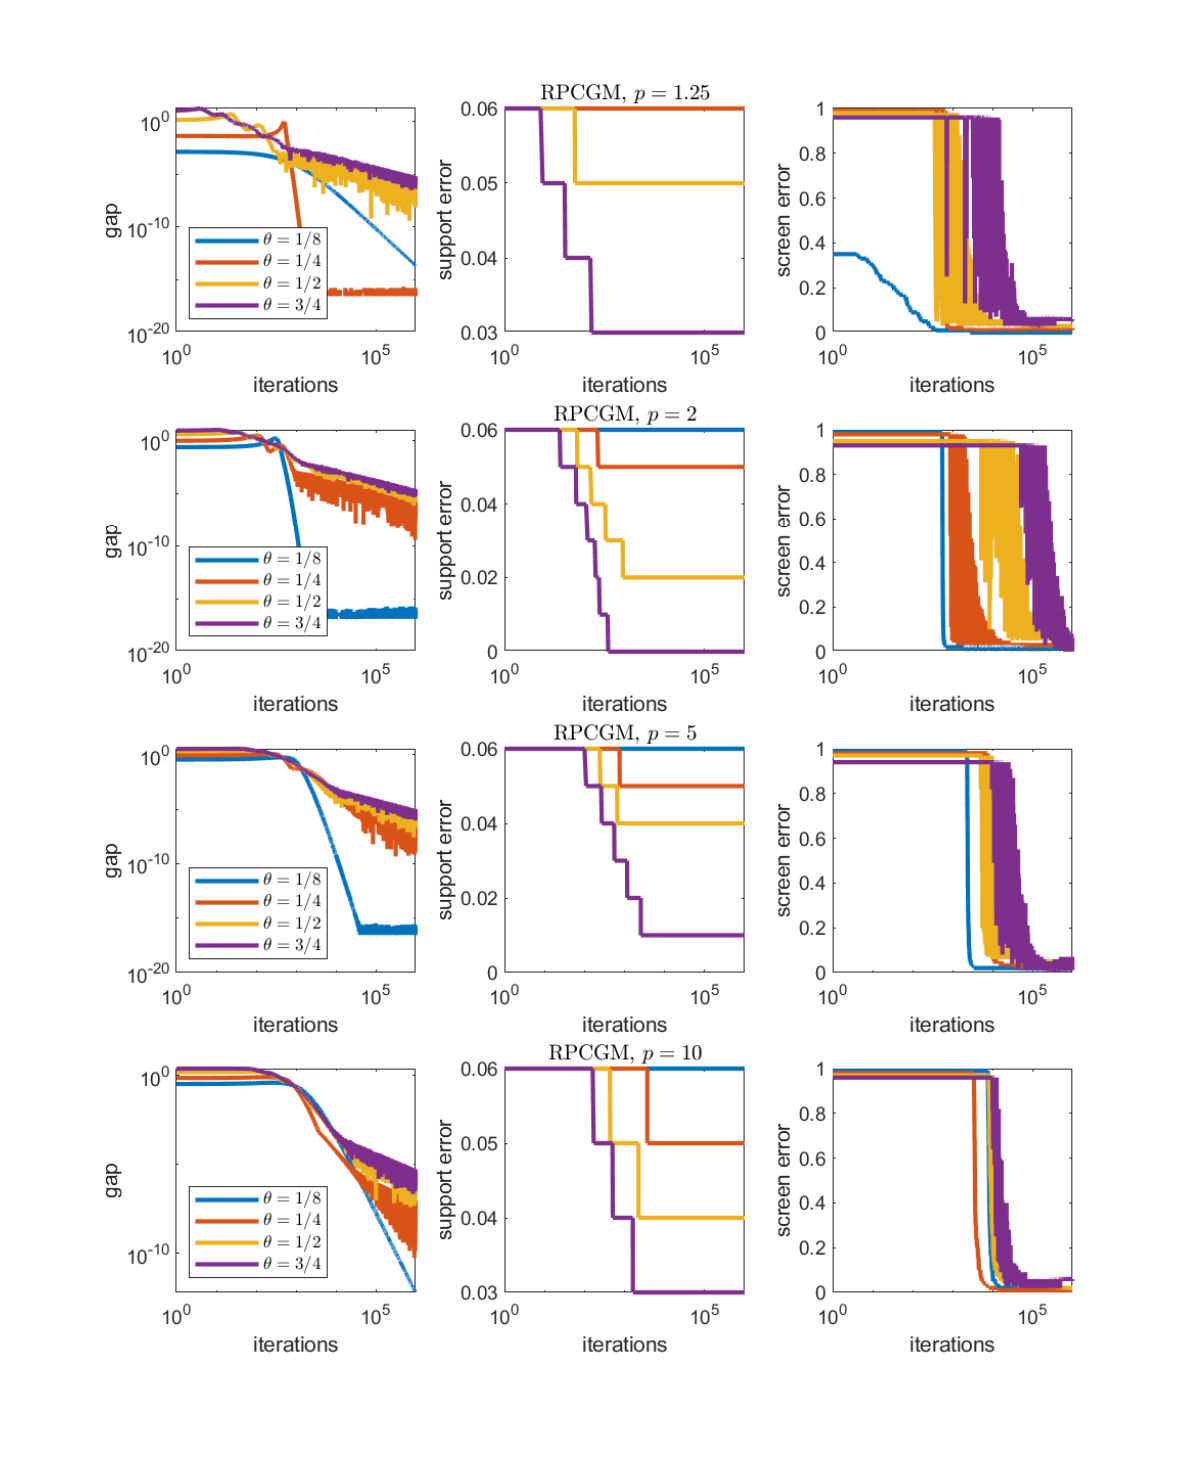
Figure 3 Small sensing experiment, RP-CGM. We again use φ ( s ) = ρ LSP function for RP-CGM ( γ ( w ) = log(1 + | w | /θ ) if | w | ≤ c , and γ ( w ) = γ 0 ( c )( w − c ) for | w | > c ). In addition to what is labeled in the figure, we use ρ = 0 . 5 , 0 . 1 , 0 . 01 , 0 . 001 for p = 1 . 25 , 2 , 5 , 10 respectively (all tuned for best performance). Additionally, we have t 0 =